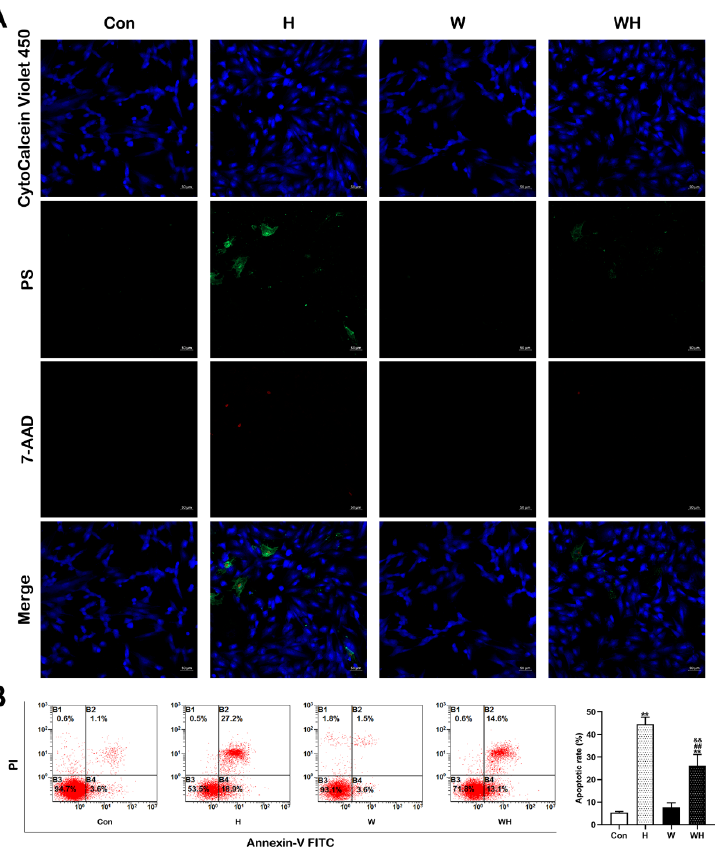
Figure 4. WA attenuated cardiomyocyte apoptosis after acute hypoxia. ( A ) Immunofluorescence analysis of normal (stained blue), apoptotic (stained green), and necrotic (stained red) cardiomyocytes. Scale bars = 50 µ m. ( B ) Flow cytometric analysis of total apoptotic cells (bottom right quadrant, viable apoptotic cells; upper right quadrant, nonviable apoptotic cells) by Annexin V and PI double staining in cardiomyocytes. The data show the mean ± SEM of three independent experiments. ** p < 0.01 vs. the Con group. ## p < 0.01 vs. the H group. && p < 0.01 vs. the W group.